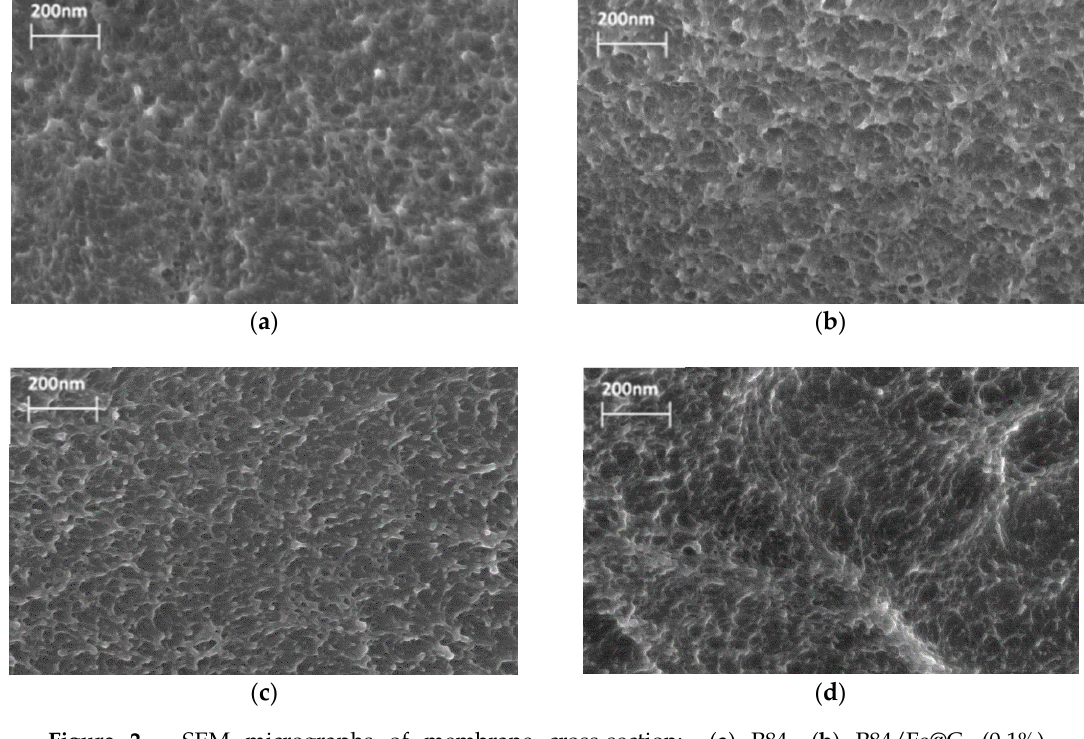
Figure 2. SEM micrographs of membrane cross-section: ( a ) Р 84, ( b ) P84/Fe@C 60 (0.1%), ( c ) P84/Fe@C 60 (0.5%), and ( d ) P84/Fe@C 60 (1%).